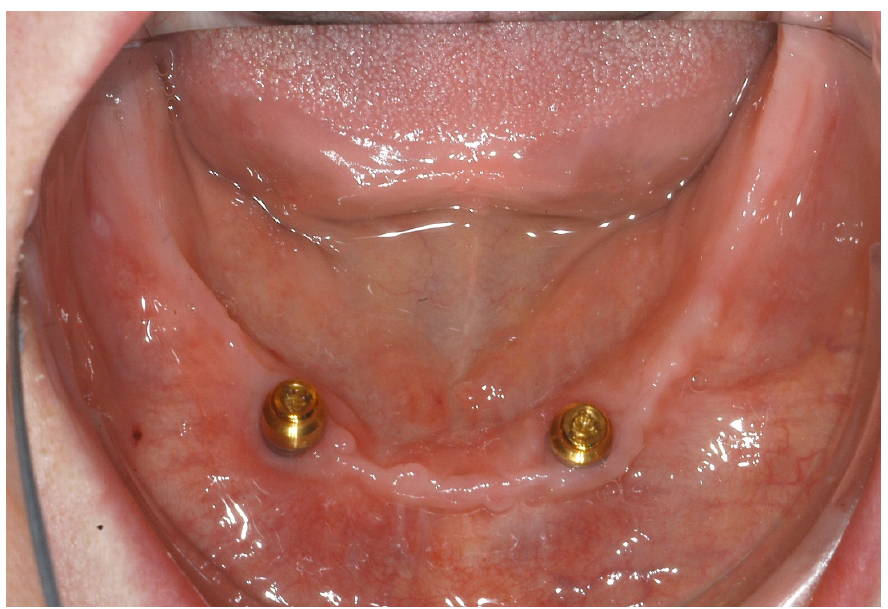
Figure 6. Prosthetic restoration with locators.